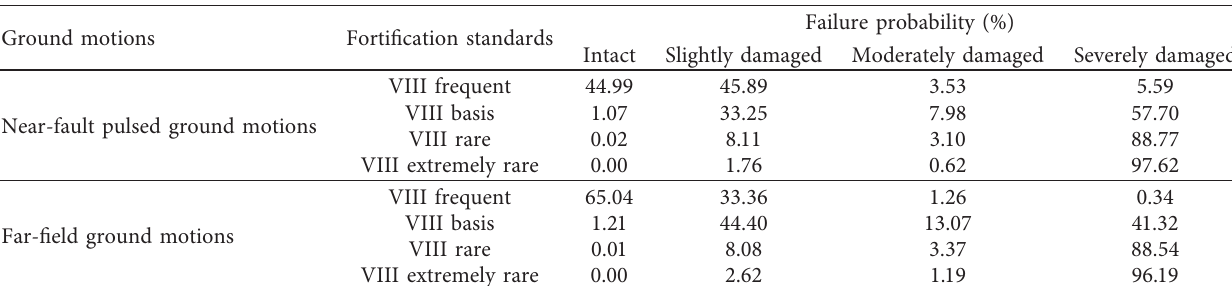
Table 8: Failure probabilities under fortification standards responding to different ground motions. Ground